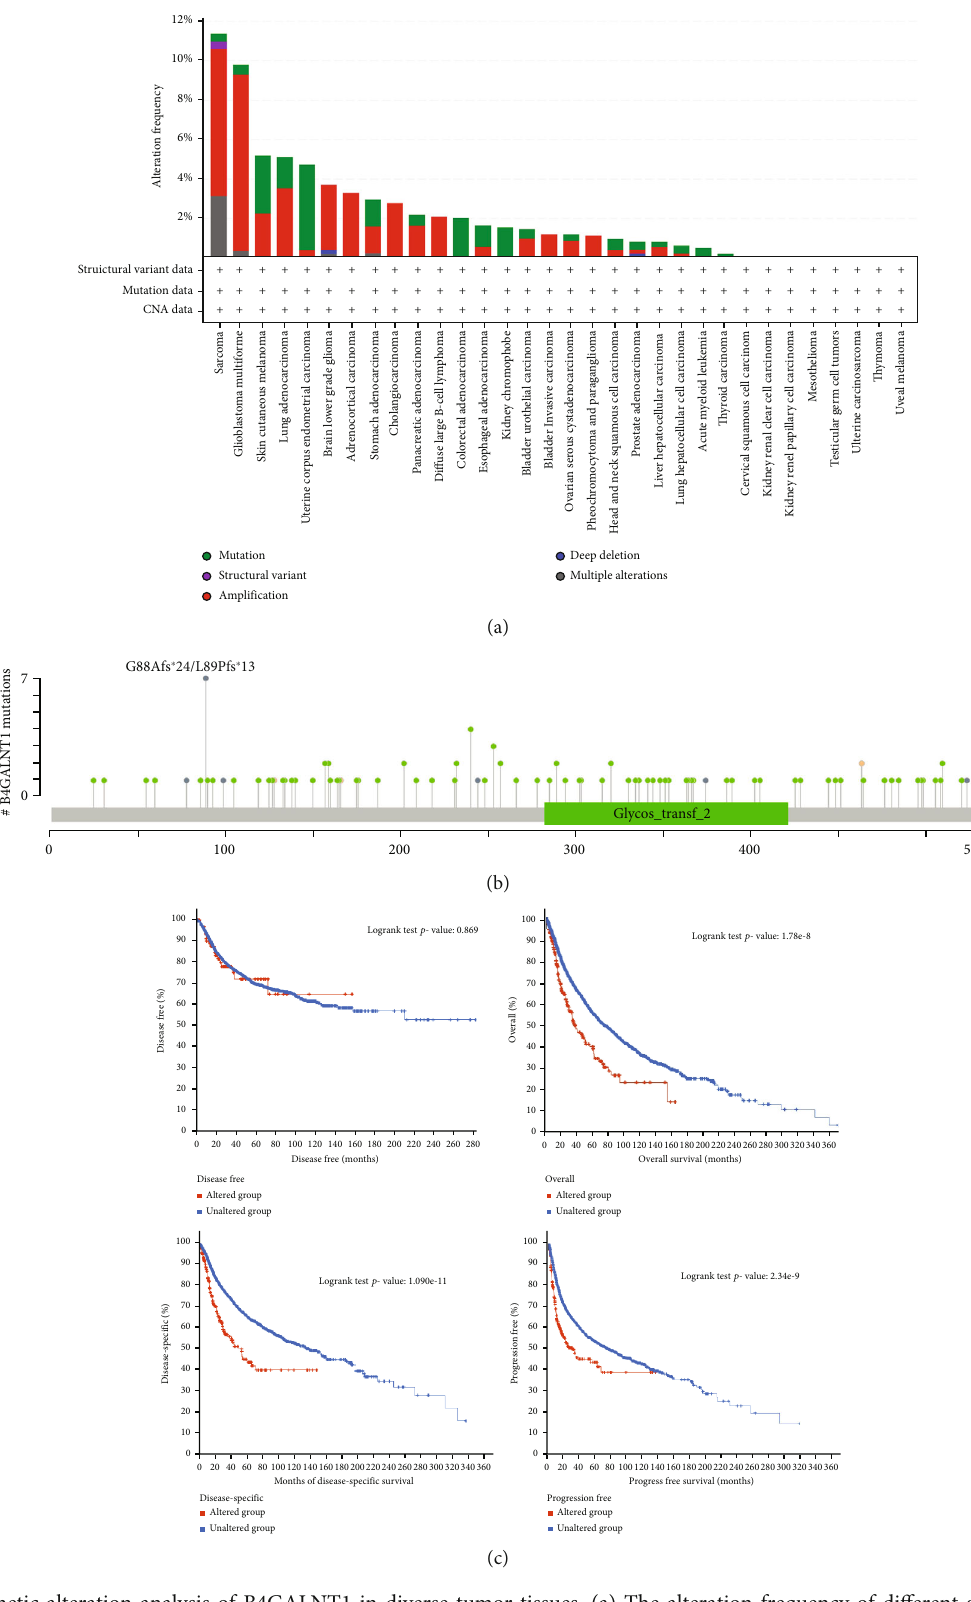
Figure 5: Genetic alteration analysis of B4GALNT1 in diverse tumor tissues. (a) The alteration frequency of di ff erent genetic alteration types of B4GALNT1 in diverse tumor samples. (b) Types and sites of B4GALNT1 genetic alteration. (c) Survival analysis of B4GALNT1 genetic alteration using Kaplan-Meier DFS, OS, DSS, and PFS in di ff erent types of